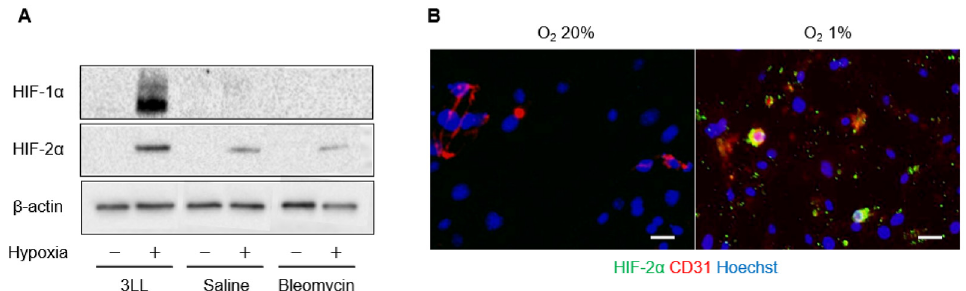
Figure 1. HIF-1 expression. ( A ) Western blot images of Lewis lung carcinoma (3LL) cells and endothelial cells from saline and bleomycin-treated lungs, cultured under normoxic (20%) and hypoxic (1%) conditions. Membranes were incubated with anti-HIF-1 α , anti-HIF-2 α , and anti- β -actin (loading control) primary antibodies. The chemiluminescence signal was detected using enhanced chemiluminescent substrate. ( B ) Representative fluorescence microscopy images of endothelial cells from bleomycin-treated lungs, cultured under normoxic (20%) and hypoxic (1%) conditions. The HIF-2 α (green) and CD31 (red) stained images were merged with nuclear stained (Hoechst, blue) images. Scale bars indicate 50 μ m.